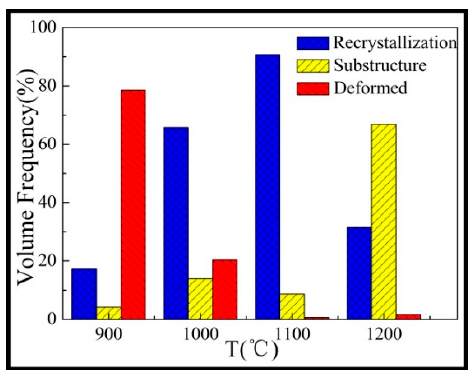
Figure 9. The volume fraction of the recrystallization grain.